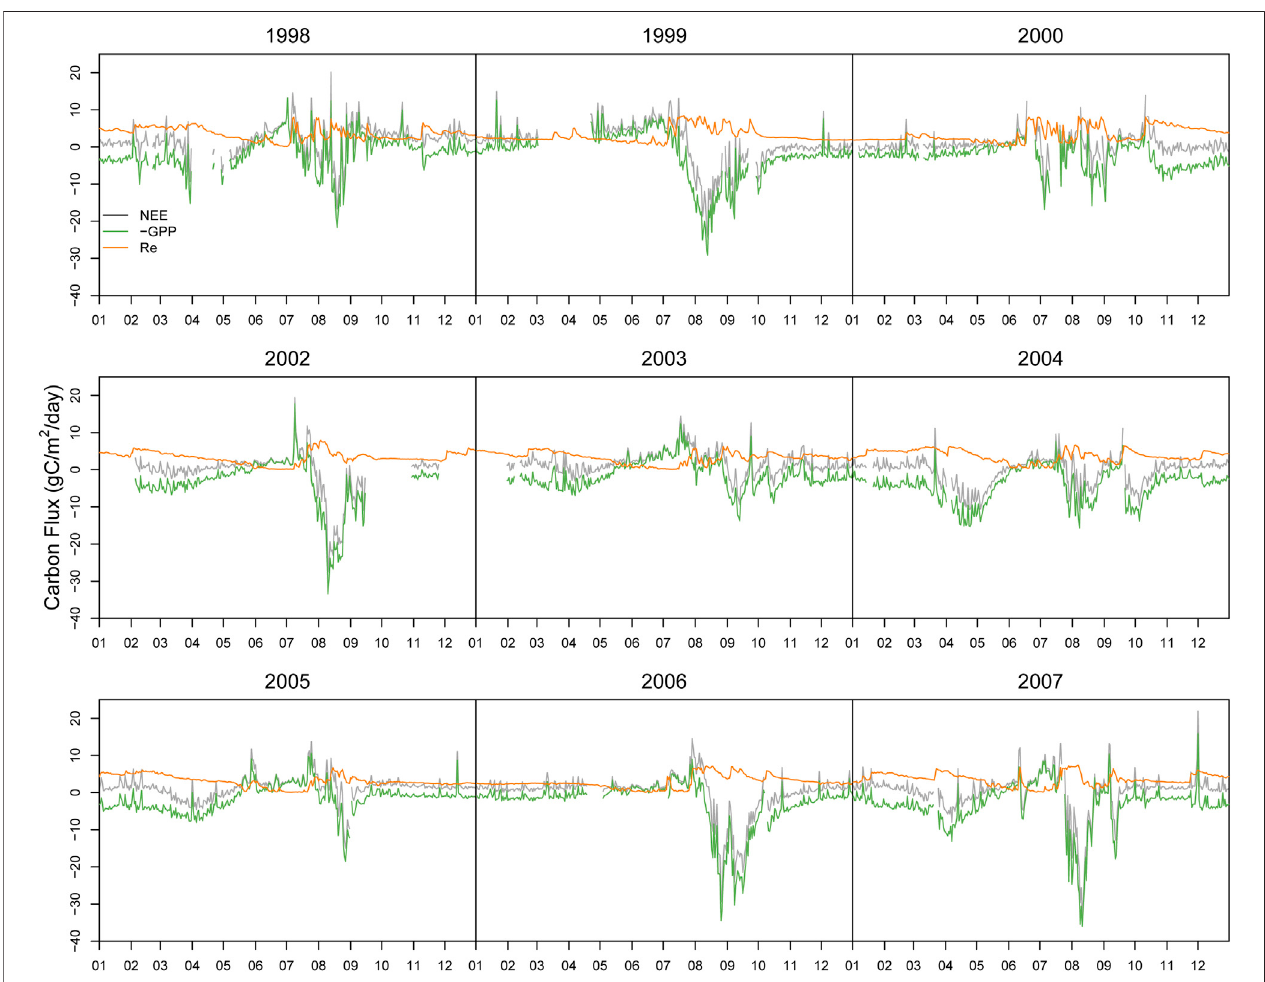
FIGURE 3 | Subdivision of measured NEE into GPP and ecosystem respiration.